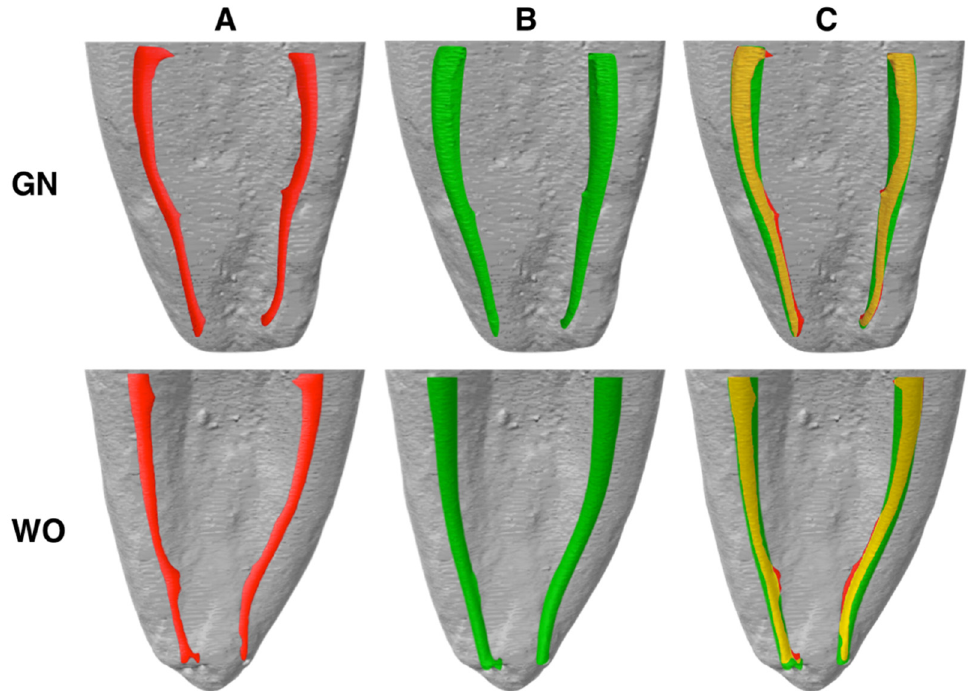
Figure 3. 3D reconstructions of the mesial root canals for Genius (GN) and WaveOne (WO) groups: preoperative reconstructions ( A ); postoperative reconstructions ( B ); superimposed reconstructions (red indicates unprepared canal surface) ( C ).